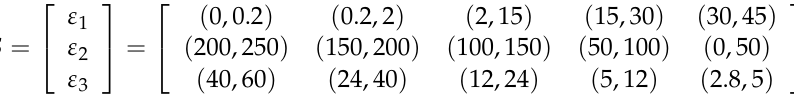
Table 1. The description of target damage level.